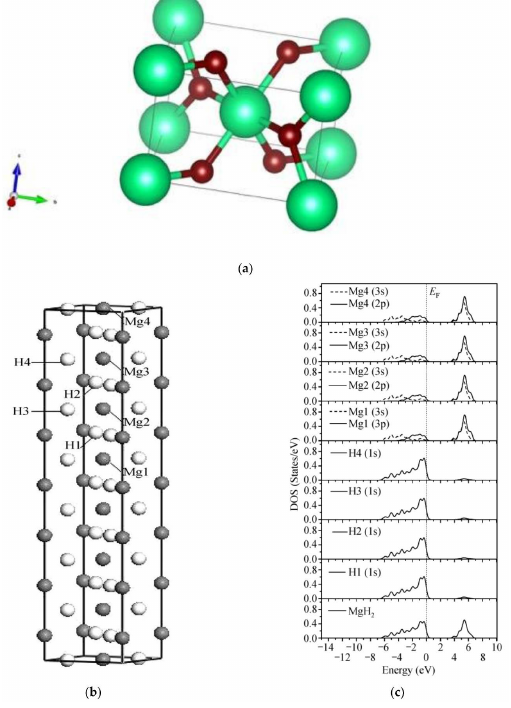
Figure 2. ( a ) Rutile crystal structure ( β -phase) of MgH 2 . ( b ) MgH 2 supercell. ( c ) Total and par- tial DOS of ( b ) MgH 2 supercell model. ( b , c ) Reproduced with permission [29]. Copyright 2006, Springer